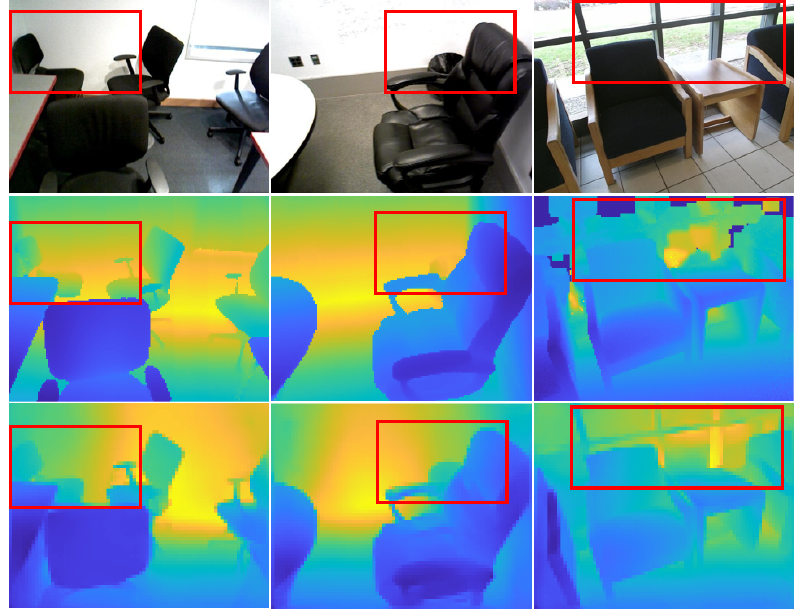
Figure 8. (row 1) Input images, (row 2) ground-truth depth, and (row 3) resulting depth images with the SUN RGB-D